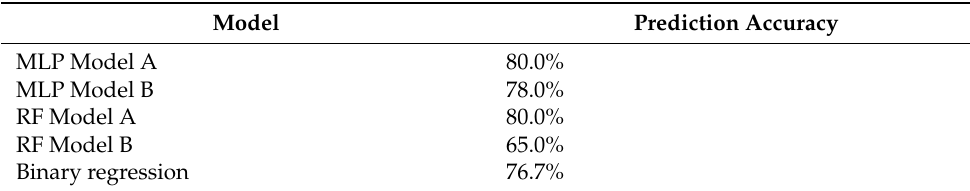
Table 6. Prediction Accuracy summary measured on the validation